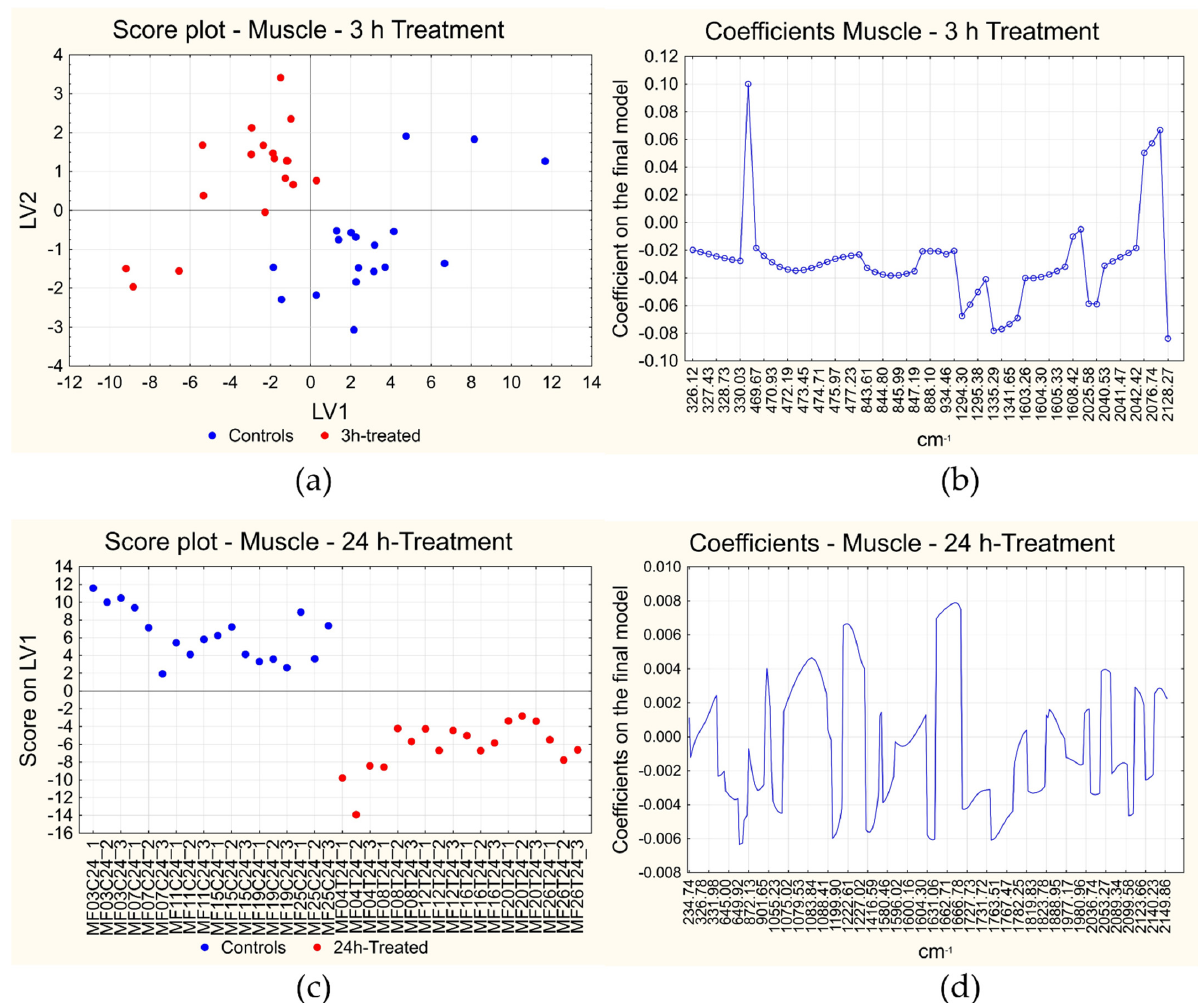
Figure 5. Results of PLS-DA on muscle. Score plot ( a ) and plot of the coefficients ( b ) of short-term treatment and long-term treatment ( c , d ). The short-term score plot reports the scores of each measurement in the space given by the first two latent variables (LVs) calculated; the long-term score plot reports the score of each measurement on the first LV (LV 1 ) on the y-axis and the measurements on the x-axis. In the score plots the samples are indicated in blue if they are controls and in red if they are treated samples. The plots of the coefficients report the variables included in the final models on the x-axis and the coefficients on the final model on the y-axis. Positive coefficients correspond to variables with a higher signal in the first derivative of treated samples, while negative coefficients correspond to variables with a lower signal in the same